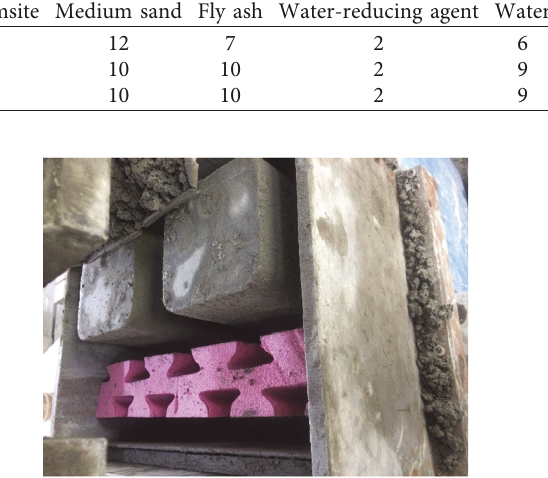
Figure 5: The extruded polystyrene heat insulation layer location in the